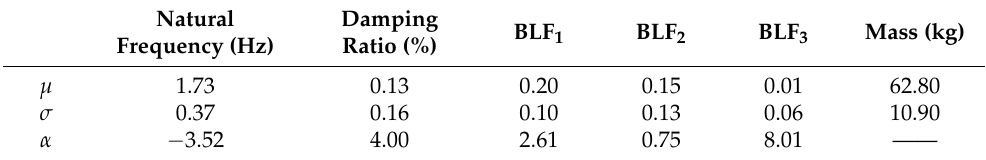
Table 2. Distribution coefficients of parameters for the analytical model, adapted from Refs. [26,29]. Natural Frequency Damping Ratio Natural (Hz)